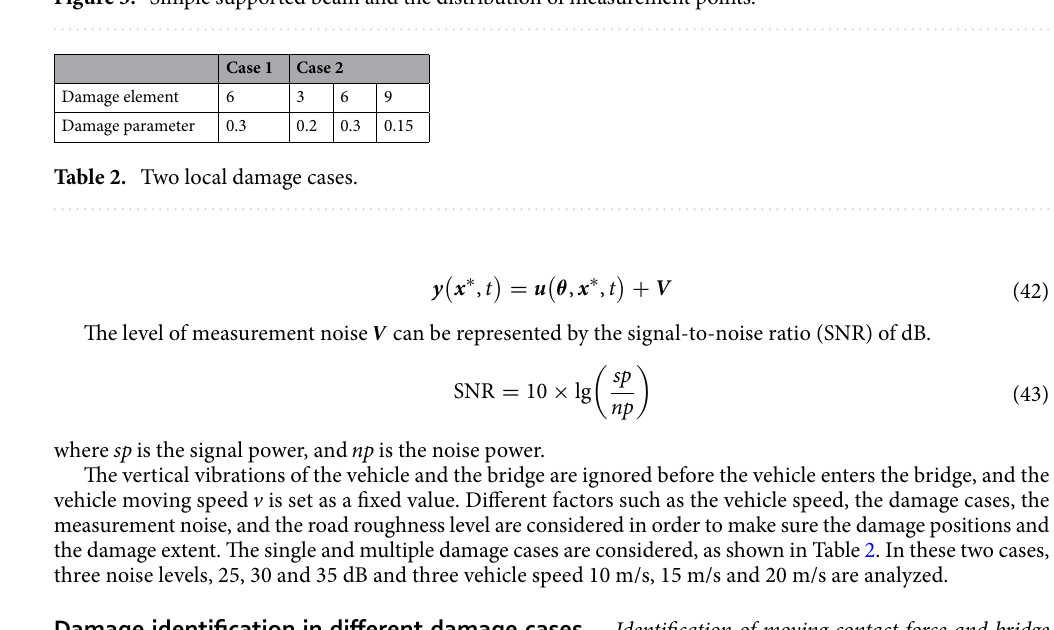
Figure 3. Simple supported beam and the distribution of measurement points.